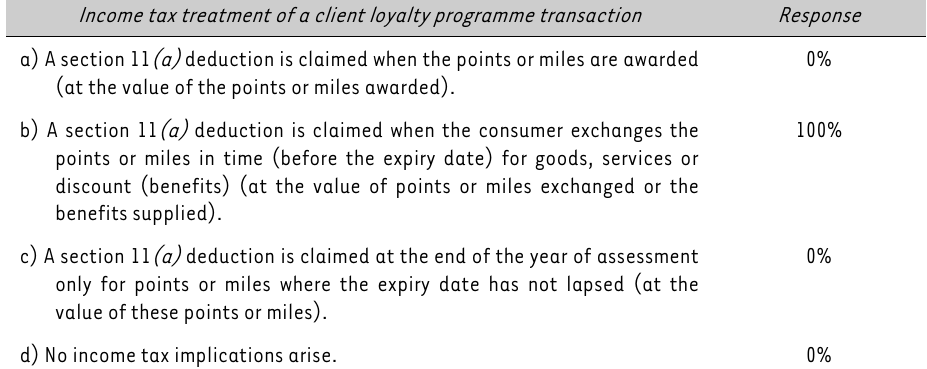
Income tax treatment of a client loyalty programme transaction for category 2 and 3 client loyalty programmes